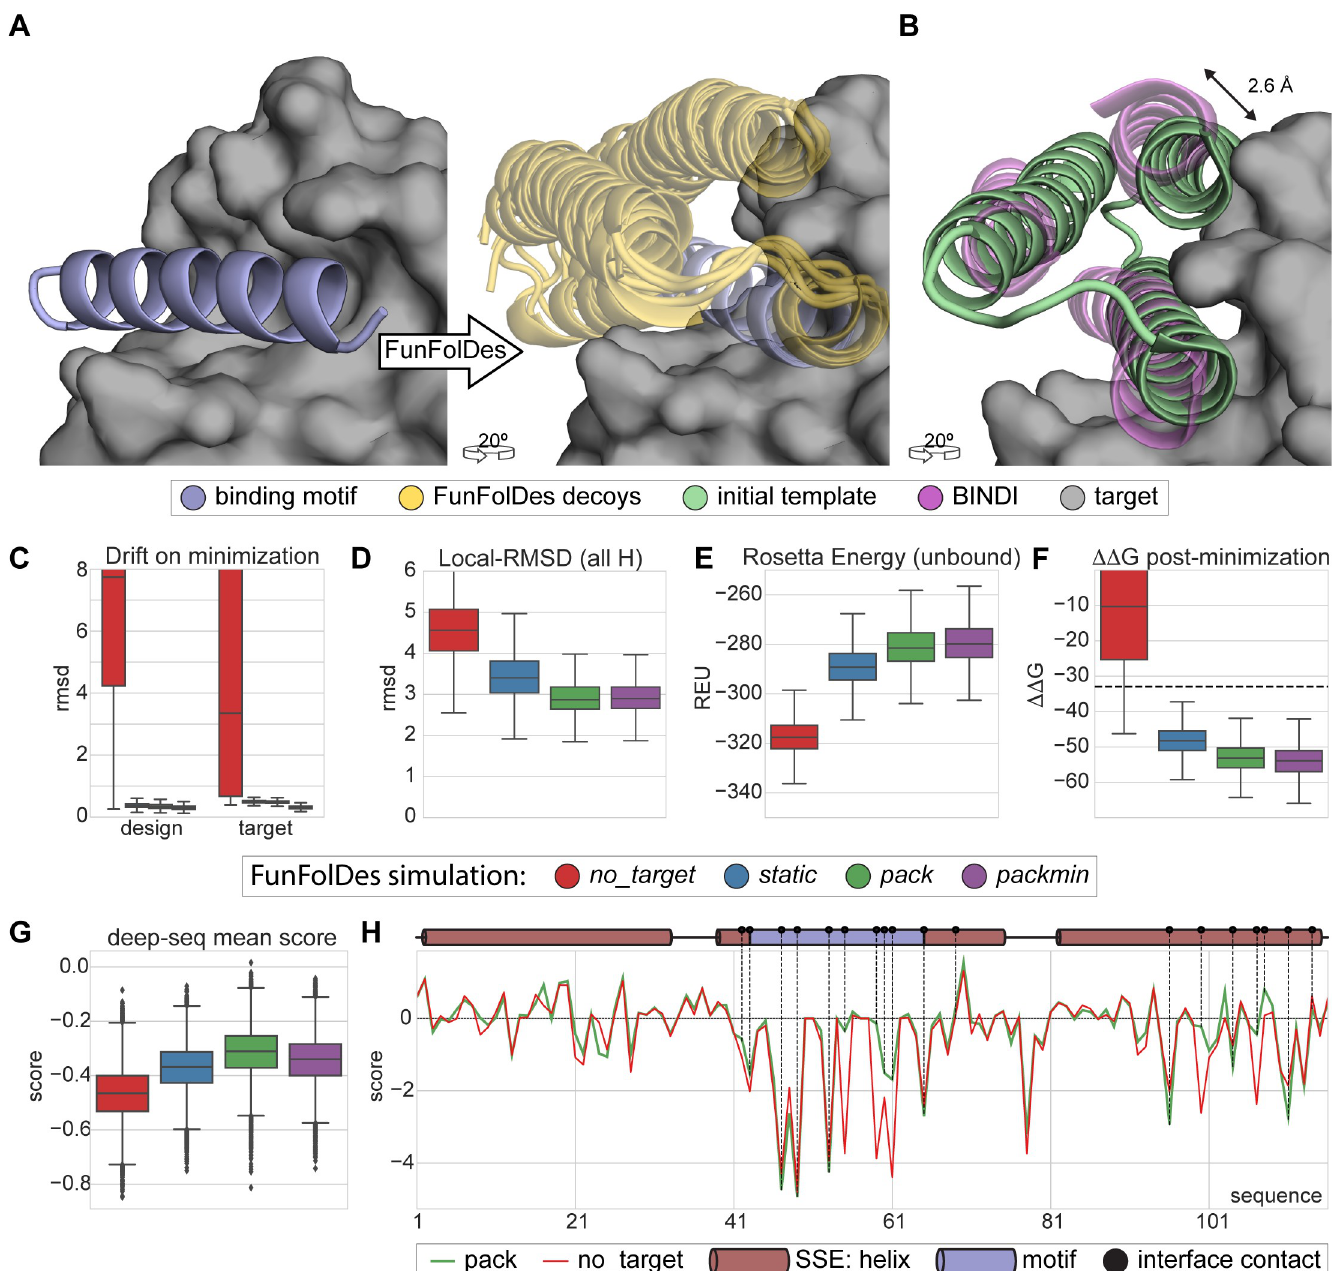
Fig 4. Target-biased design of a protein binder and performance assessment based on saturation mutagenesis. A) Depiction of the initial design task, a single- segment binding motif (BIM-BH3) shown in light blue cartoons, with its target (BHRF1) shown in gray surface, is used by FunFolDes to generate an ensemble of designs compatible with the binding mode shown in light orange cartoons. B) Conformational difference between the initial template (PDB ID: 3LHP), shown in light brown and the previously designed binder (BINDI), shown in violet cartoons, helix 3 requires a subtle but necessary shift (2.6 Å ) to avoid steric clashes with the target. C-G) Scoring metrics for design populations according to the simulation mode: no_target —FunFolDes was used without the target protein; static —target present no flexibility allowed; pack —target allowed to repack the side-chains; packmin –side-chain repacking plus minimization and backbone minimization were allowed for the target. The target flexibility was allowed during the relax-design cycles of FunFolDes. C) Structural drift observed for design and target binder measured as the RMSD between pre- and post-minimization conformations. D) Structural recovery of the conformation observed in the BINDI-BHRF1 assessed over the 3 helical segments of the bundle. E) Rosetta energy for the designs in the unbound state generated by different simulation modes. F) Interaction energy ( ΔΔ G) between the designs and the target. G) Deep-sequencing score distribution for each design population, computed as the mean score of each sequence after applying a position score matrix based on the deep-sequencing data. The pack population slightly outperforms the other simulation modes. H) Per-residue scoring comparison of the no_target and the pack populations according to the deep-sequencing data. Although the behavior is overall similar, pack outperforms no_target in multiple positions, several of which are highlighted (black dots) as interfacial contacts or second shell residues close to the binding